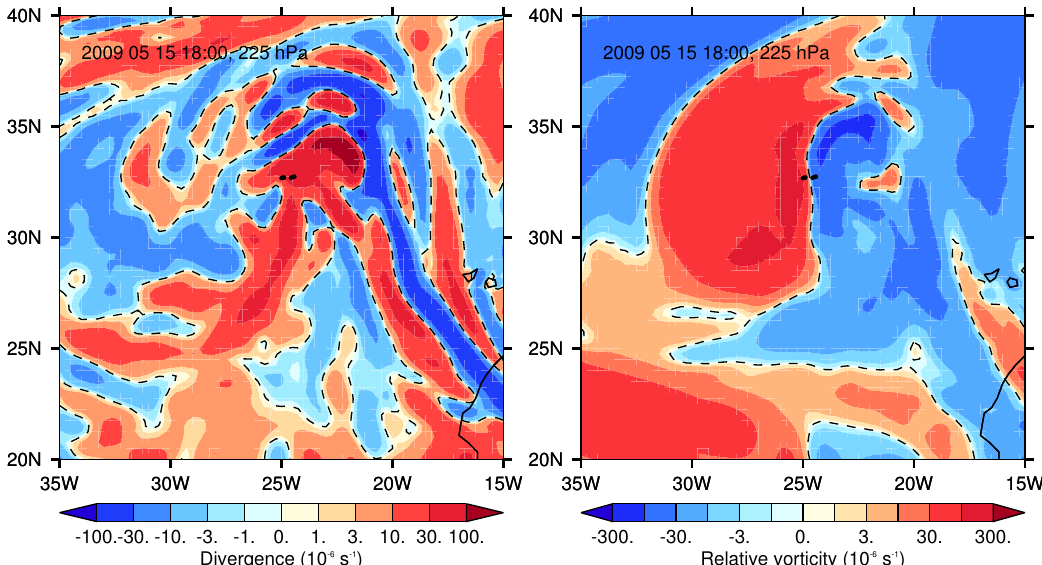
Figure 9. ( Left ): Horizontal divergence for the situation of Figure 5. ( Right: ) Relative vorticity for the same case. The black dashed line marks in both cases zero, that is, the transition from convergence to divergence in the left panel and the transition from cyclonic to anticyclonic rotation in the right